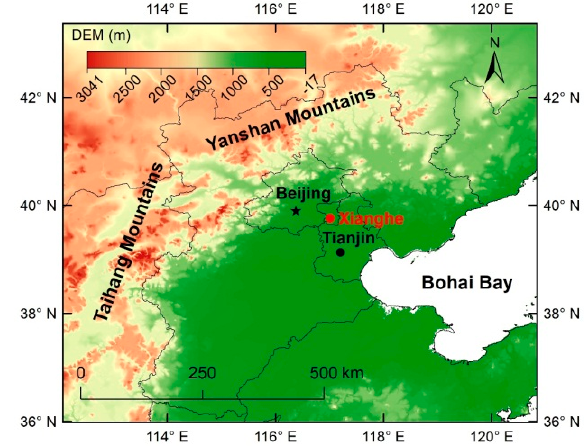
Figure 1. Location of the NH 3 observation site in Xianghe.